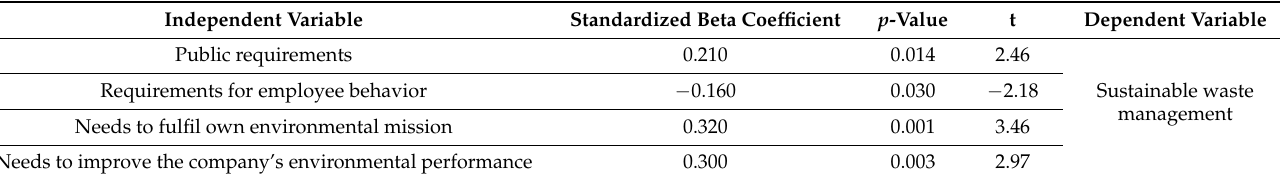
Table 7. Factors influencing the application of sustainable waste